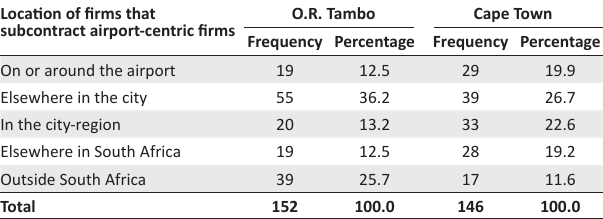
TABLE 6: Location of firms that subcontract the airport-centric firms. Location of firms that subcontract airport-centric